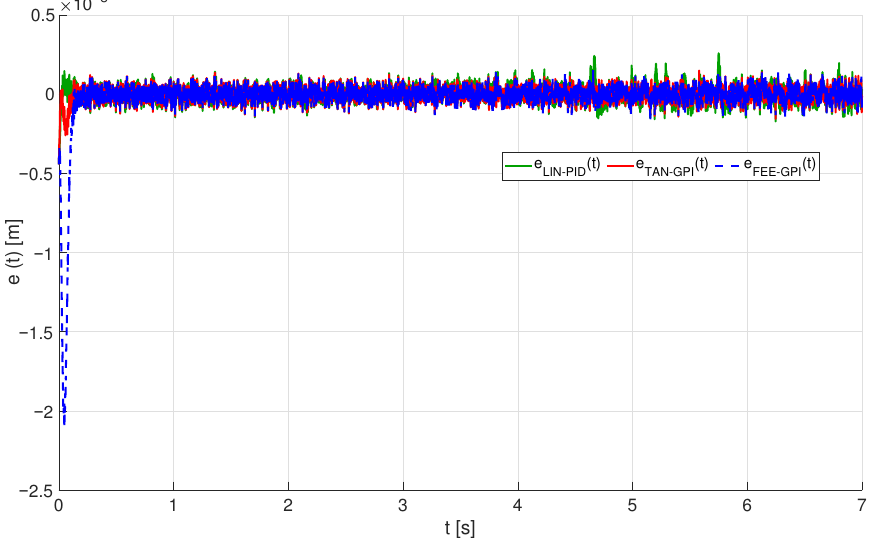
Figure 10. Evolution of tracking error trajectory of the magnetic ball, e ( t ) = y ( t ) − y ∗ ( t )[ m ] , with mea- surement noises and controller gain mismatches (Test